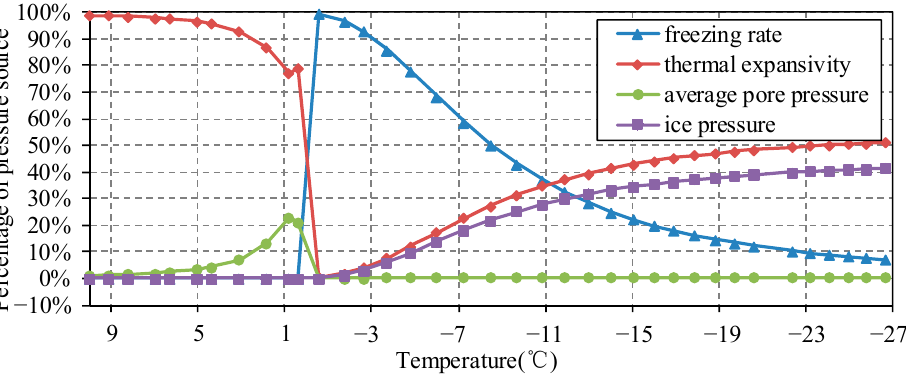
Figure 6. The source analysis of water pressure in low temperature process.